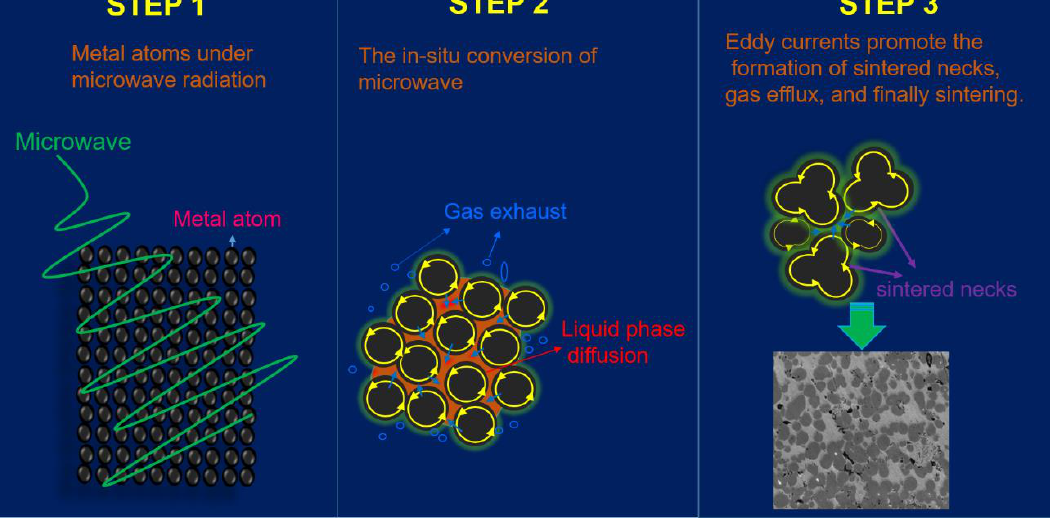
Figure 11. The schematic diagram of a possible mechanism for the microwave pressureless sintering.